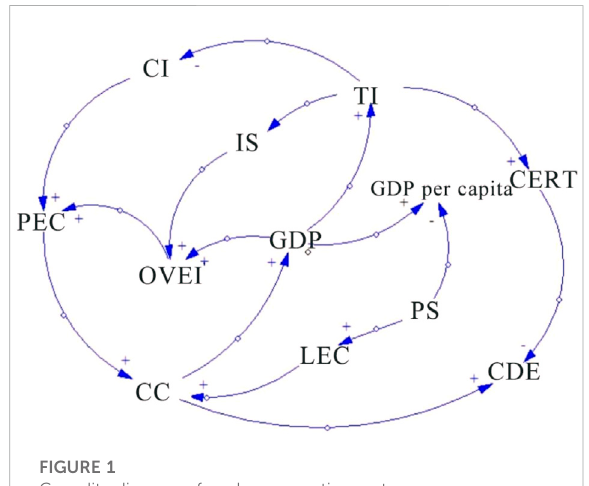
FIGURE 1 Causality diagram of coal consumption